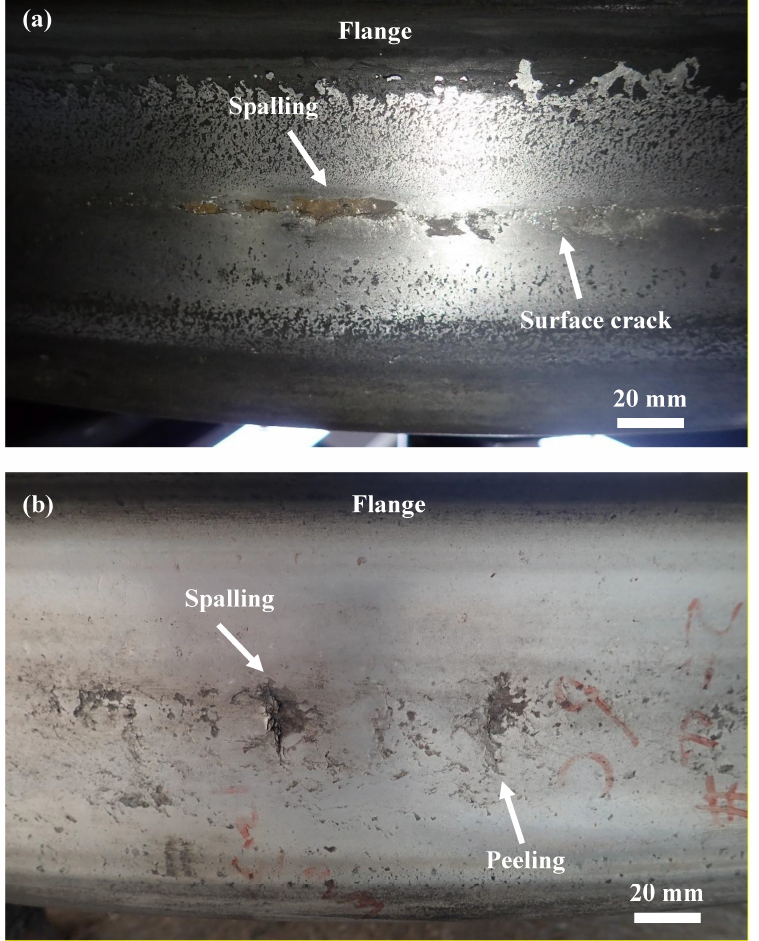
Figure 1. Two typical surface-initiated rolling contact fatigue features for wheels that show ( a ) spalling and cracking and ( b ) spalling, peeling and cracking. Wheel–rail contact can be simplified as a solid wheel rolling on an infinite plane. Ac- cording to the shakedown map theory by Johnson et al. [19,20], the shakedown limit of the wheel can be obtained by Equation (1).